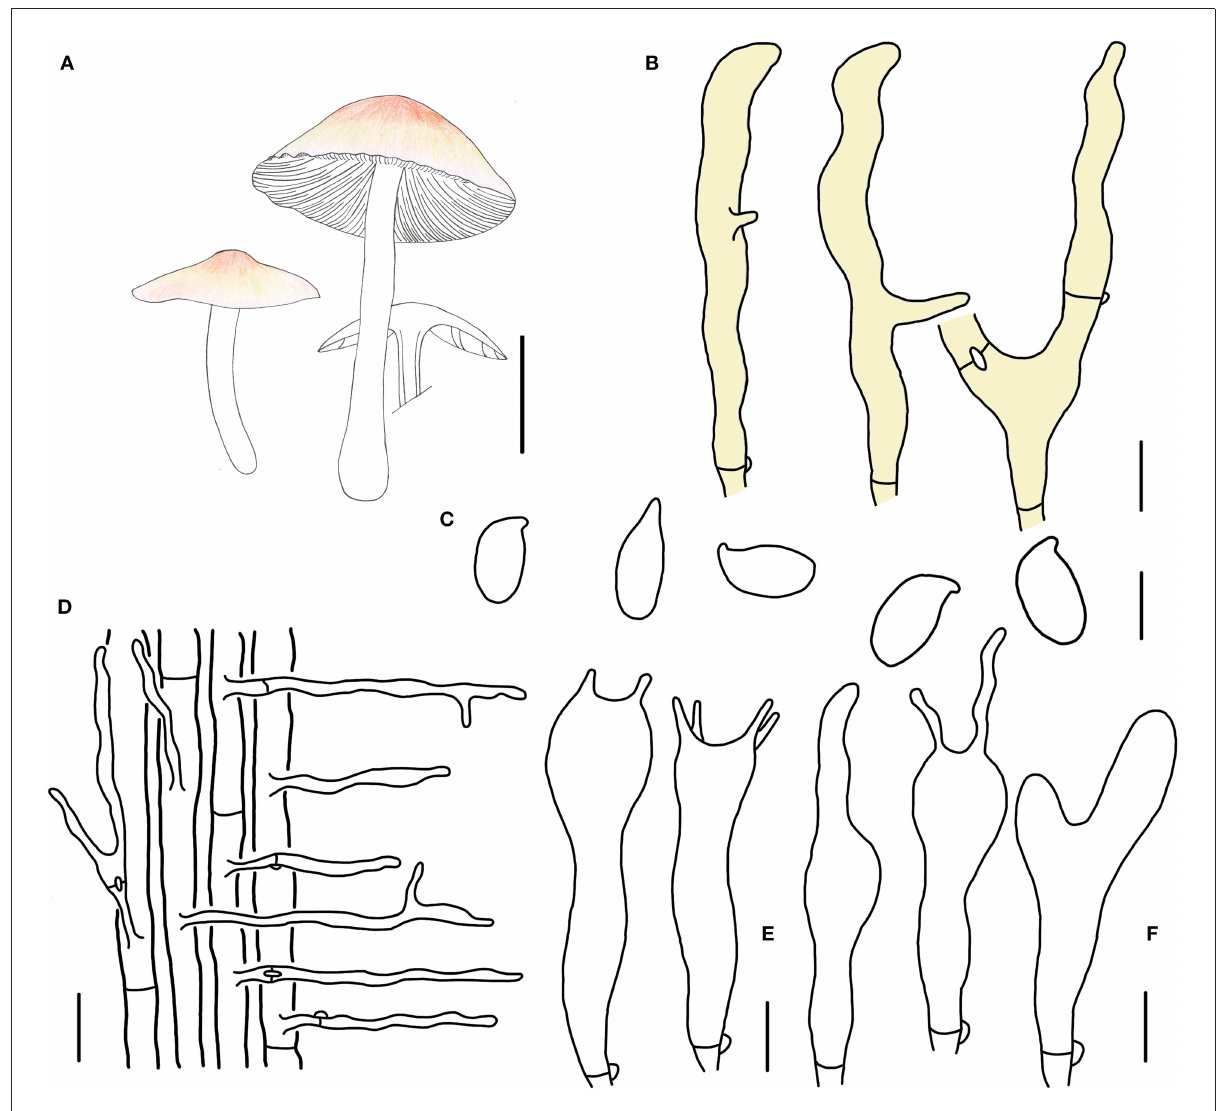
FIGURE6 Morphological characteristics of Gymnopus subpolyphyllus (HMJAU 60999, holotype). (A) Basidiomata; (B) Pileipellis elements; (C) Basidospores; (D) Caulocystidia; (E) Basidia; (F) Cheilocystidia; Scale bars: 1cm (A) ; 10 µ m (B) ; 5 µ m (C,E,F) ; 20 µ m (D) .